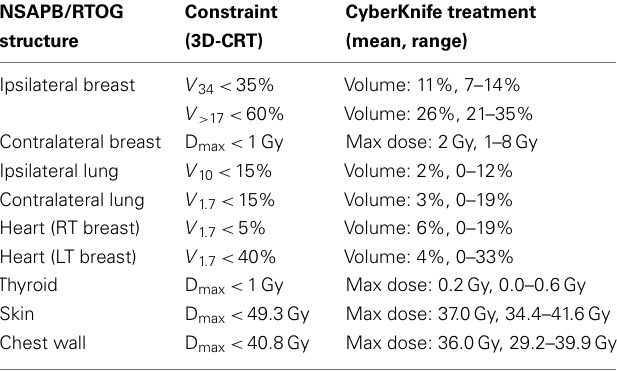
Table 3 | Dose limitations for normal tissue based on the NSABP-39/RTOG 0413, 3D-CRT protocol (Vicini andWhite, 2007) for the patients in this series ( n = 7) that received CyberKnifeAPBI to a total dose of 34Gy delivered in 10